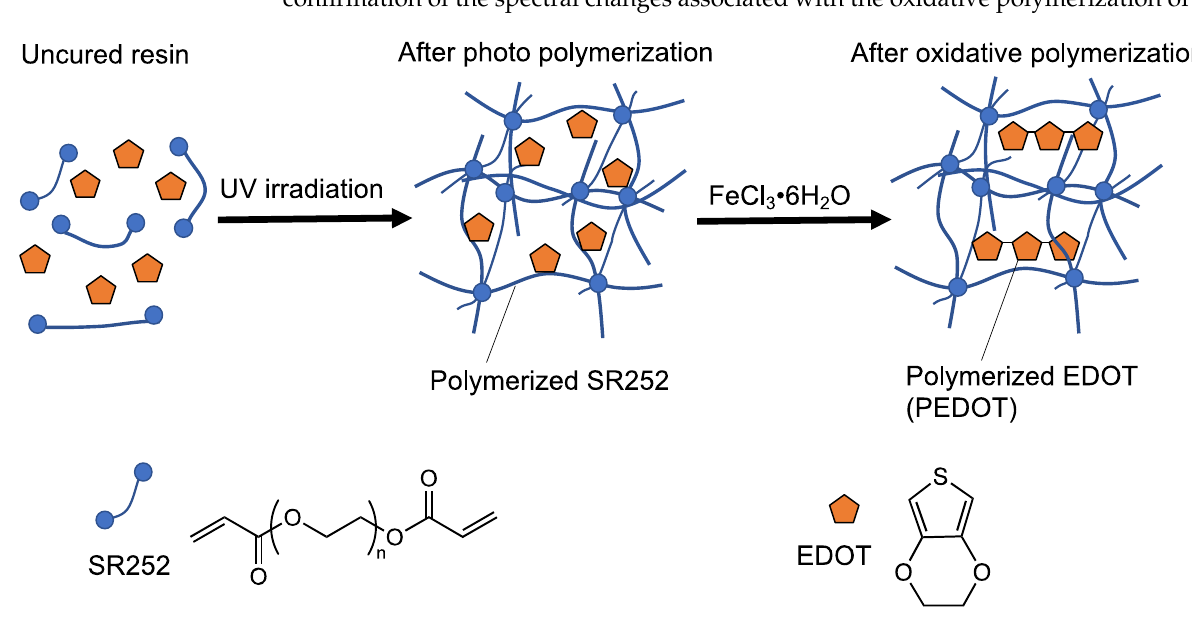
Figure 3. Schematic of expected chemical structure change for each process. The ATR-FTIR spectra of the uncured resin, photopolymerized resin UV-irradiated for 15 min, and oxidative polymerization resin treated with FeCl 3 · 6H 2 O are shown in Figure 4. In all the spectra, peaks were observed at 2859 cm –1 , attributed to the symmetrical stretching vibration of CH 2 with SR252, and 1712 cm –1 , attributed to the carbonyl group (C=O) stretch vibration. The peak originating from SR252 appears strong because SR252 accounts for a large proportion of the resin composition. In the uncured resin, the 1624 cm –1 peak originating from SR252 acrylate (C=C stretch vibration) was observed (Figure 4, bottom spectra), but the peak decreased significantly after photopolymerization (Figure 4, middle spectra) and oxidative polymerization (Figure 4, upper spectra). This means that the acrylate groups disappeared owing to photopolymerization. The adjusted uncured resin containing EDOT was a clear liquid (Figure 5a). However, after UV irradiation, it was a transparent solid, which can also be explained by the fact that SR252 formed a cross- linked structure following photopolymerization (Figure 5b). Further, it remains transparent, suggesting that EDOT has not polymerized. The 754 cm –1 , 892 cm –1 , and 1185 cm –1 peaks were derived from the C-H stretch vibration, out-of-plane vibration of =C-H, and in-plane vibration of =C-H in EDOT, respectively [32]. This peak was observed in the uncured resin (Figure 4, bottom spectra) and sample after photopolymerization (Figure 4, middle spectra) and nearly disappeared after oxidative polymerization (Figure 4, upper spectra). Because EDOT is not involved in photopolymerization and the solid after photopolymerization exhibits almost no liquid release, it can be designated as an organogel with EDOT as the solvent (Figure 5b). The decrease in those peaks’ intensity after oxidative polymerization is presumably due to the loss of hydrogen atoms ( α - α ’ coupling) on the thiophene ring associated with PEDOT formation [32,33]. The formation of PEDOT can also be